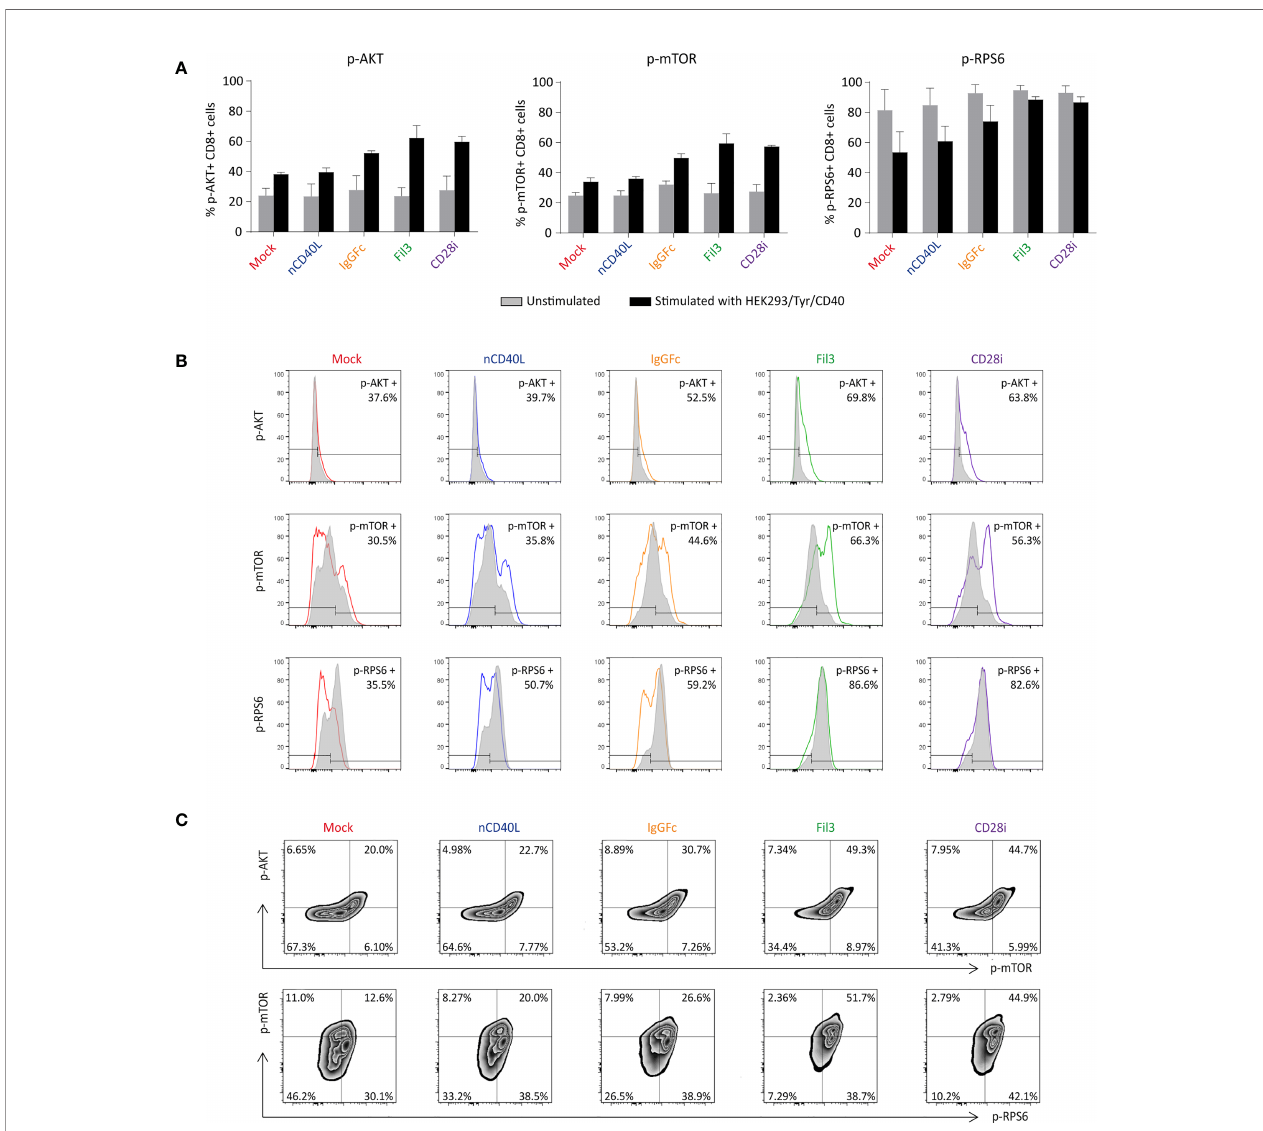
FIGURE 9 | Biological activity of the CD28 ICD within the CSPs by measuring the phosphorylation of AKT, mTOR and RPS6. CD40L:CD28 CSP-expressing TCR- T58 T cells were thawed and re-activated to induce CSP expression as described in Figure 7 . On day 6, they were stimulated with HEK293/Tyr/CD40 for 30 min. Unstimulated T cells were used as a negative control. (A) Graphs depict the percentage of phosphorylated p-AKT, p-mTOR and p-RPS6 in T cells after 30 minutes co-culture, grey bars correspond to the unstimulated controls and black bars correspond to the stimulated T cells. Bars are the mean values of the percentages of three independent experiments. The error bars are the standard deviation. (B) Histograms depicting the fl uorescence intensity of each phosphorylated protein in T cells expressing the different CSPs; unstimulated (grey histogram) and after stimulation (colored histograms). (C) Density plots showing the correlation between p- AKT with p-mTOR and p-mTOR with p-RPS6 in T cells expressing the different CSPs. Mock-transduced T cells (red) and T cells transduced to express the native CD40L (blue) were used as references. T cells transduced with CD40L:IgGFc:CD28 are depicted in orange, those with CD40L:Fil3:CD28 CSP are depicted in green and T cells with CD40L:CD28i CSP are depicted in